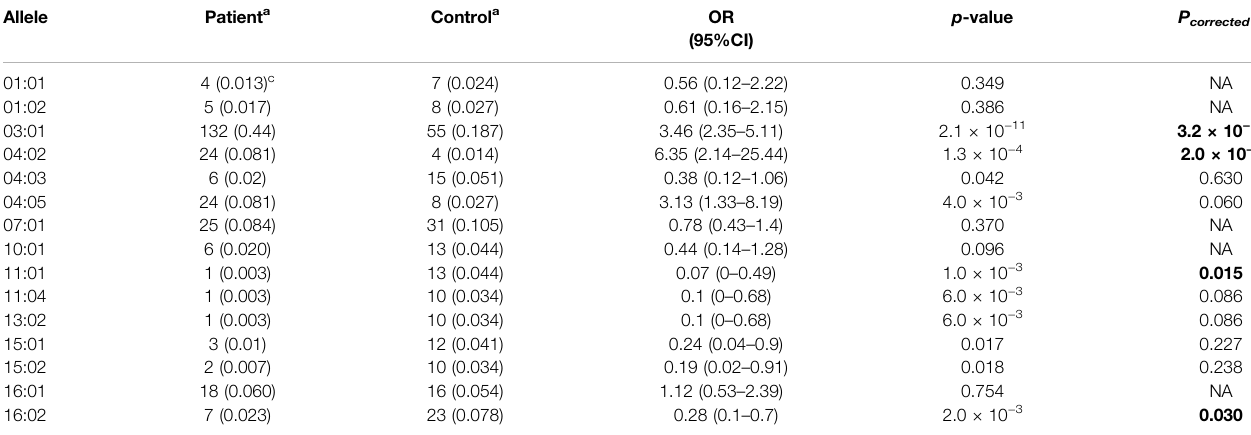
TABLE 2 | Associations of DRB1 alleles with T1D in Emirati study subjects. Allele Patient a